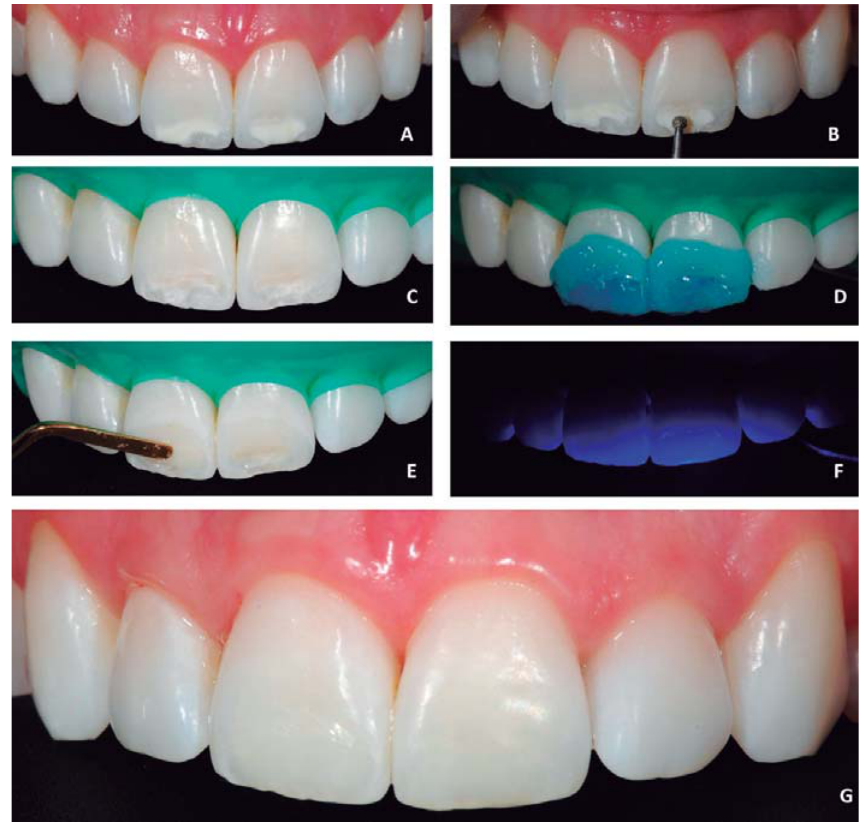
Figure 5- A: A teenage boy had deep white enamel stains on the maxillary central incisors; B: Removal of the remainder (cid:4)(cid:27)(cid:12)(cid:14)(cid:5)(cid:18)(cid:12)(cid:8)(cid:24)(cid:19)(cid:4)(cid:3)(cid:16)(cid:8)(cid:7)(cid:12)(cid:13)(cid:5)(cid:10)(cid:14)(cid:18)(cid:12)(cid:18)(cid:19)(cid:8)(cid:16)(cid:18)(cid:7)(cid:12)(cid:13)(cid:10)(cid:14)(cid:5)(cid:12)(cid:8)(cid:12)(cid:22)(cid:19)(cid:18)(cid:23)(cid:14)(cid:8)(cid:2)(cid:18)(cid:3)(cid:18)(cid:20)(cid:12)(cid:20)(cid:10)(cid:8)(cid:16)(cid:4)(cid:19)(cid:20)(cid:12)(cid:24)(cid:15)(cid:3)’(cid:12)()(cid:12)(cid:29)(cid:4)(cid:4)(cid:14)(cid:5)(cid:12)(cid:2)(cid:3)(cid:18)(cid:2)(cid:8)(cid:3)(cid:8)(cid:14)(cid:10)(cid:4)(cid:19)(cid:12)(cid:27)(cid:4)(cid:3)(cid:12)(cid:17)(cid:4)(cid:16)(cid:2)(cid:4)(cid:11)(cid:10)(cid:14)(cid:18)(cid:12)(cid:3)(cid:18)(cid:11)(cid:10)(cid:19)’(cid:12)*)(cid:12)+(cid:14)(cid:17)(cid:5)(cid:10)(cid:19)(cid:25)(cid:12)(cid:27)(cid:4)(cid:3)(cid:12) 30 seconds with 35% phosphoric acid; E: After water rinsing and air drying, a two-step bonding agent was applied. Resin- based composite restoration was performed; F: Complete photo-polymerization was accomplished using a light beam of 1000 mW/cm²; G: Finishing and polishing were completed using high speed diamond burs and low speed points